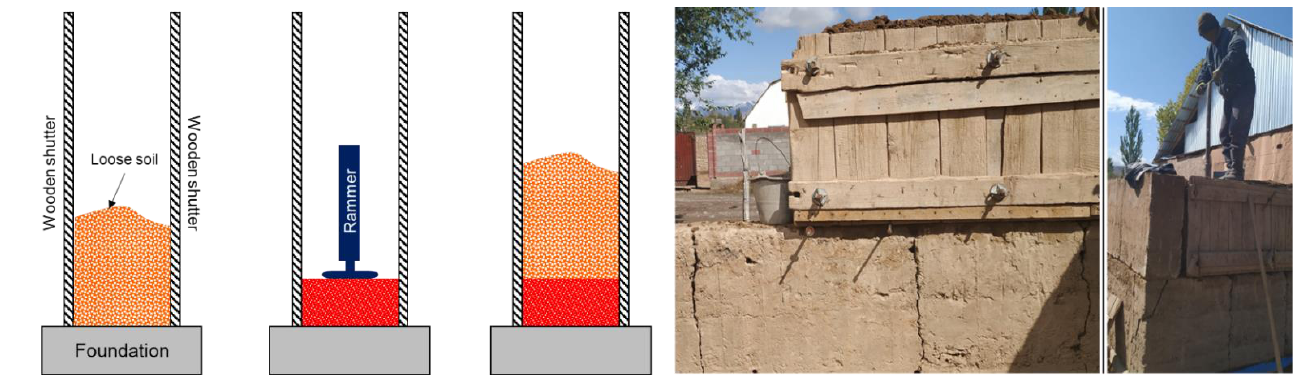
Figure 12. Rammed earth construction principles ( left ) and practice in rural Kyrgyzstan ( right ).